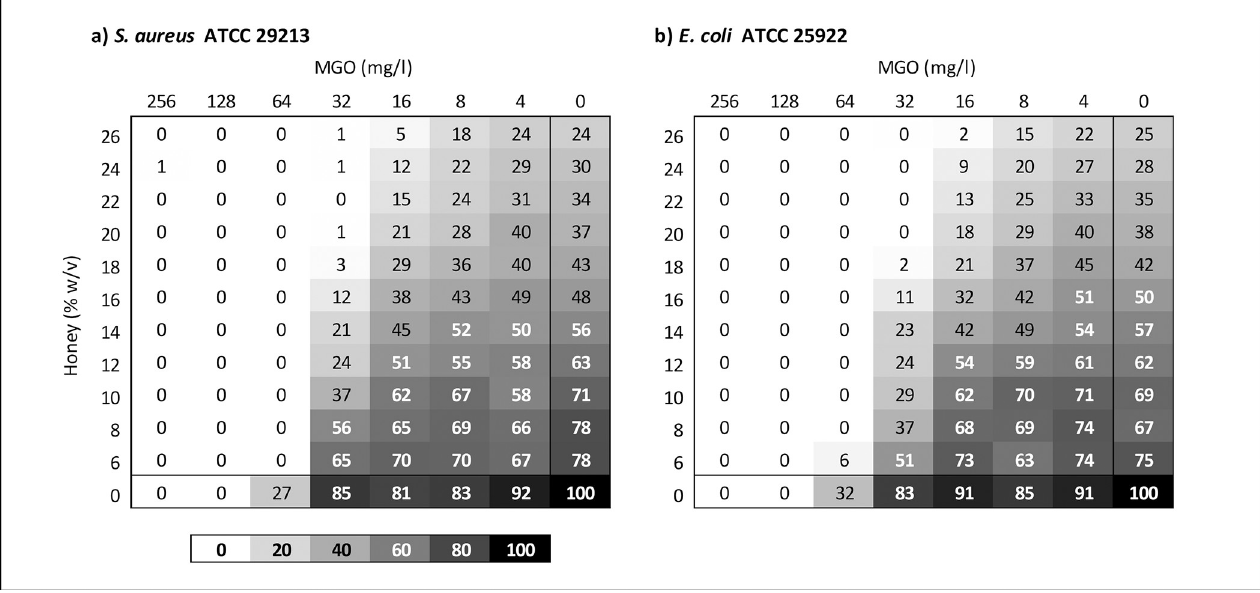
Fig 2. Heat maps of checkerboards showing multifloral honey in combination with